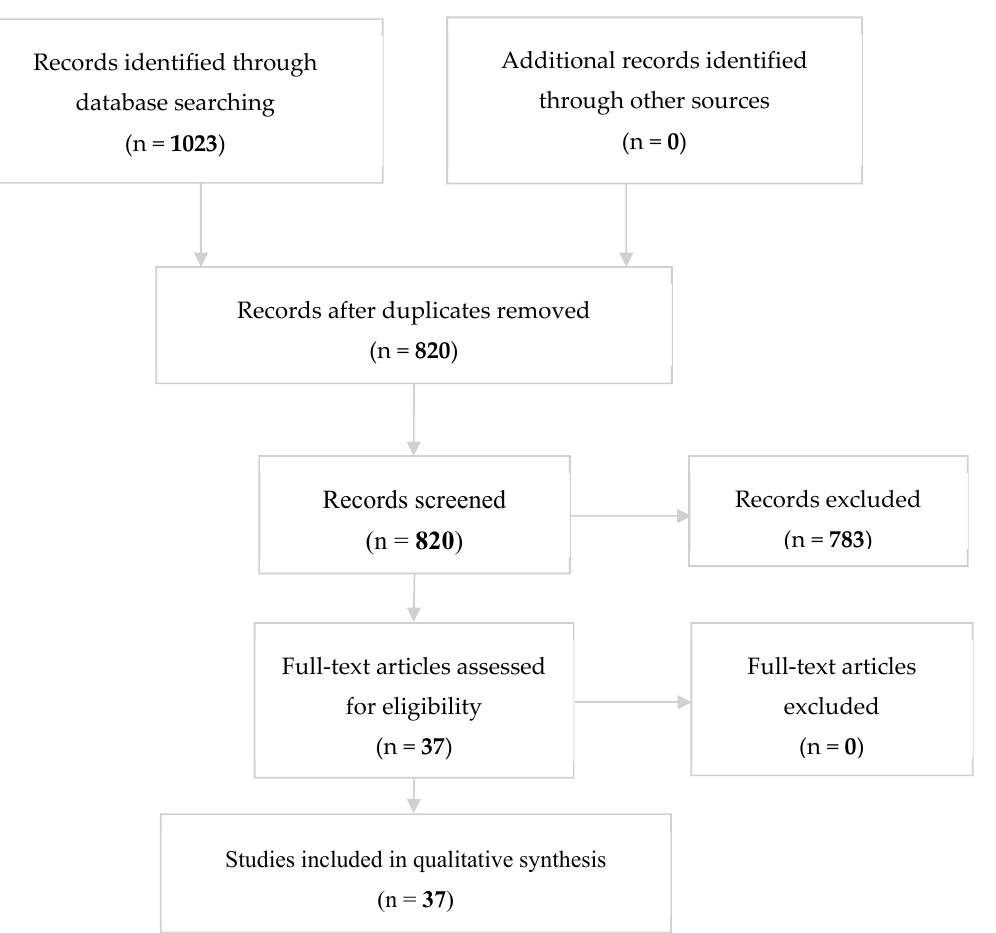
Figure 2. Systematic flow-chart representing study inclusion.